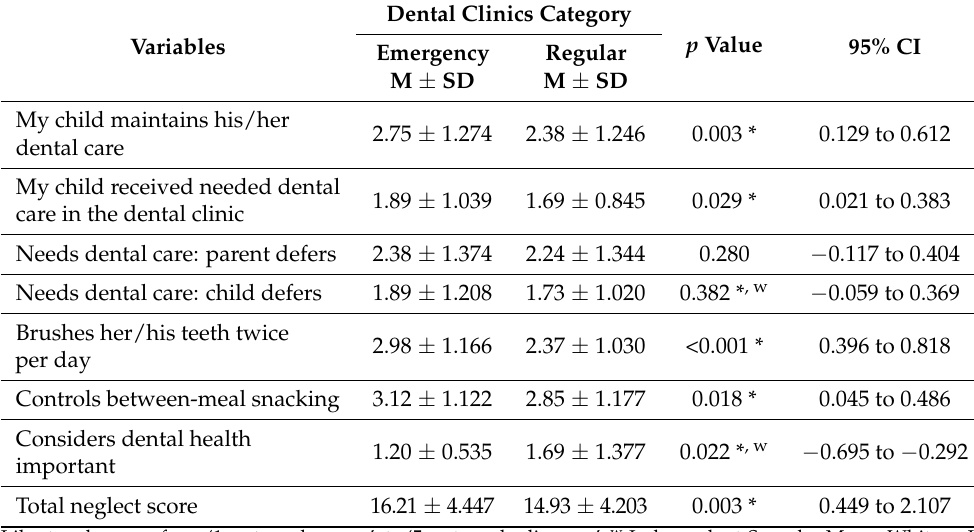
Table 2. Mean dental neglect score for children visiting emergency clinics compared to regular dental clinics.